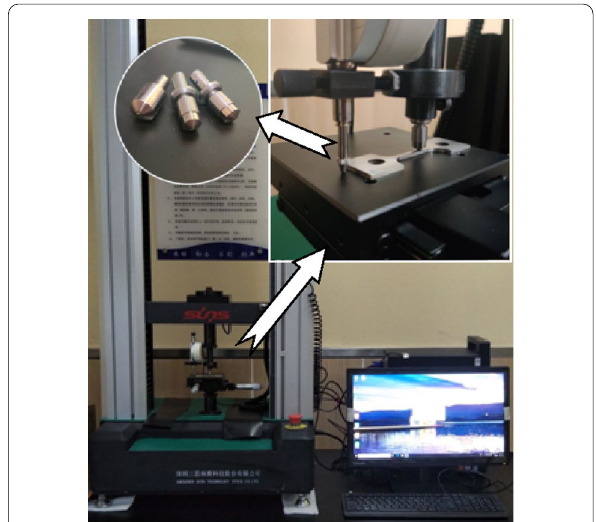
Figure 7 Indentation test system